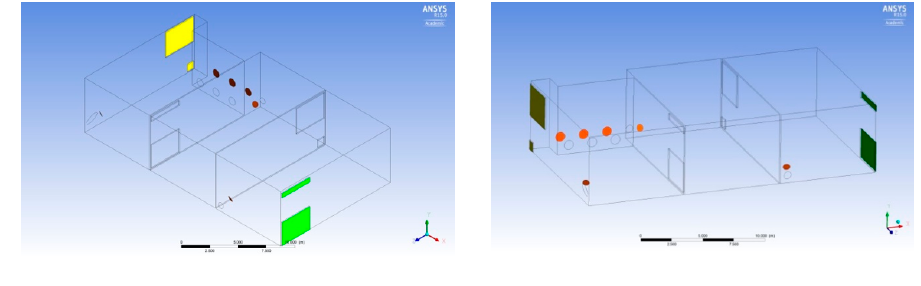
Figure 3. Geometry with mesh and define functions [15].